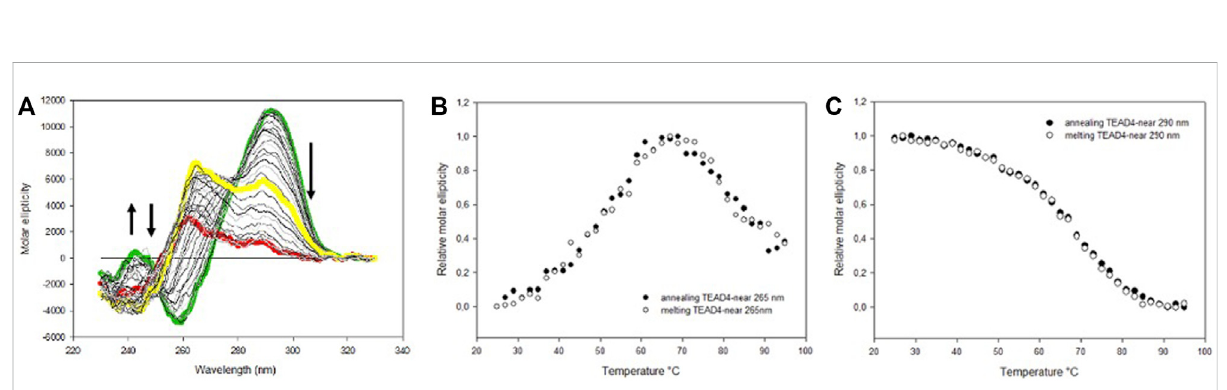
FIGURE 3 (A) CD spectra of 4 µM TEAD4-near in 5 mM Tris pH 7.5, 150 mM KCl, acquired at increasing temperatures. The green, yellow and red lines correspond to spectra acquired at 25, 70 and 95 ° C, respectively. (B) and (C) Variation of the relative molar ellipticity at 265 and 290 nm, respectively, recorded during the annealing and the melting of 4 µM TEAD4-near in 5 mM Tris pH 7.5, 150 mM